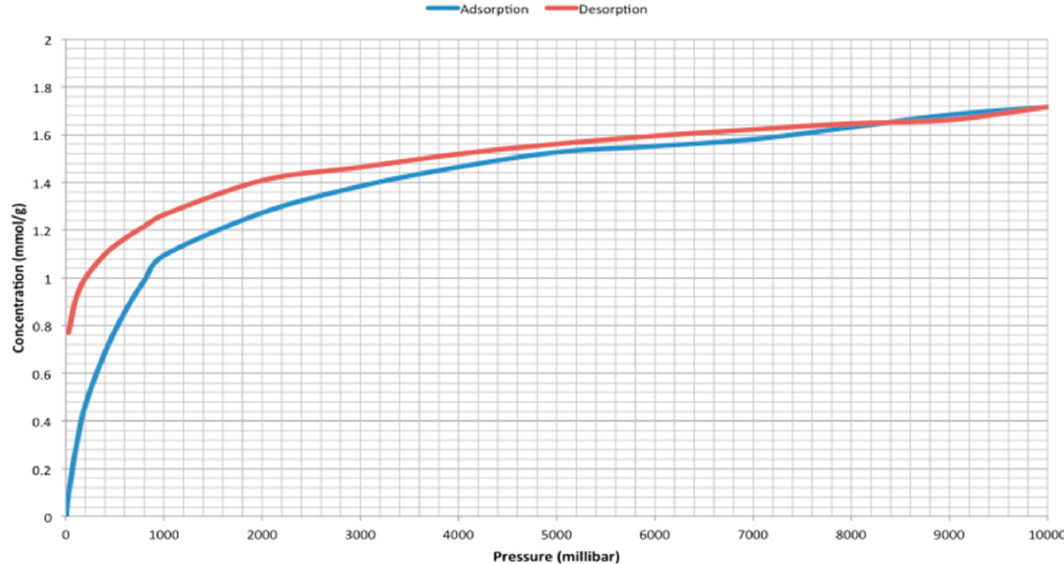
· 3 H 2 O at 273 4